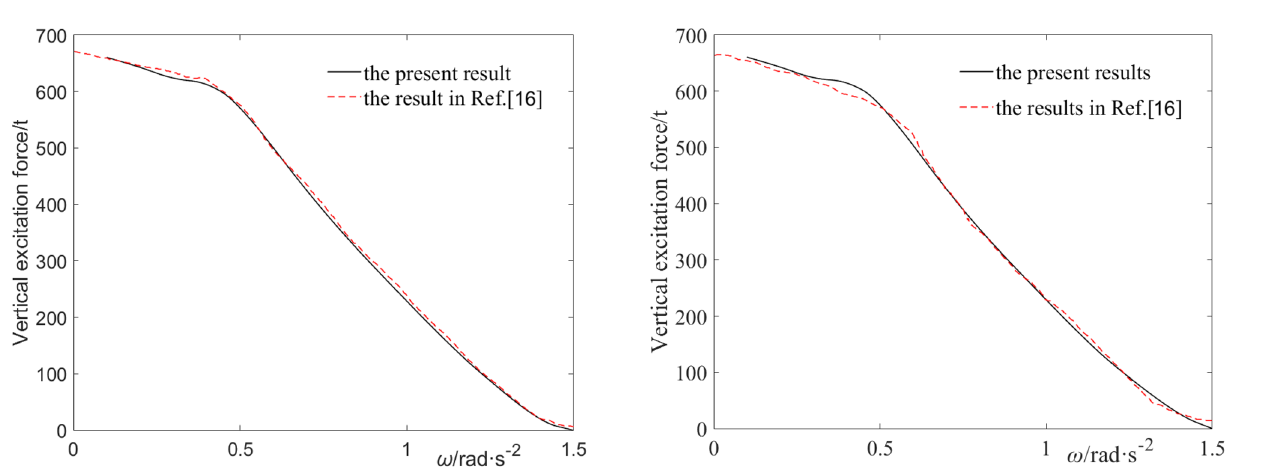
Fig. 3 Influence of wave frequency on the vertical force for the 4th pontoon ( 𝛽 = 0 ◦ )